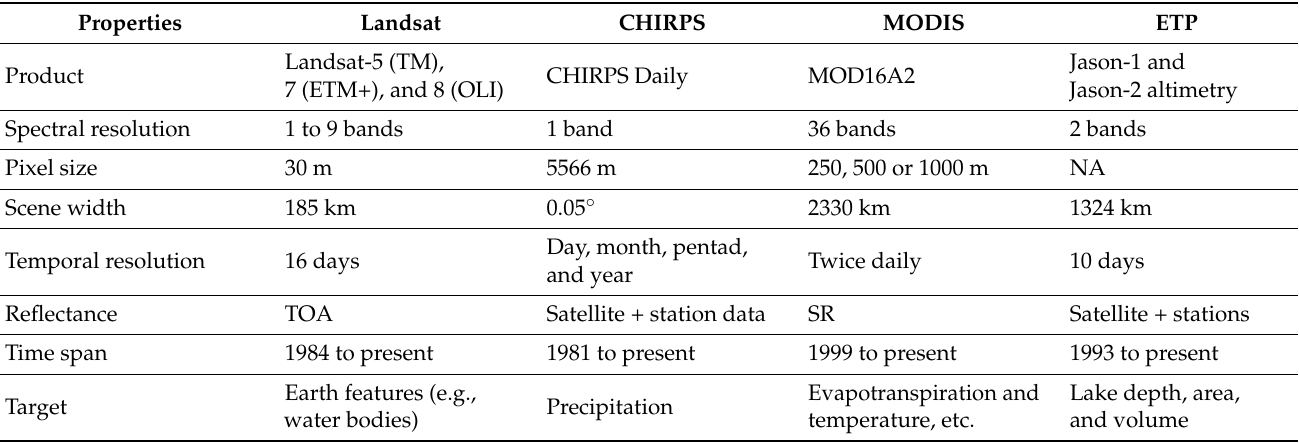
Table 1. Summary of the remote sensing products used in the study. TOA stands for top of atmo- spheric reflectance, SR—surface reflectance, TM—Thematic Mapper, ETM+—Enhanced Thematic Mapper, OLI—Operational Land Imager, and NA—not